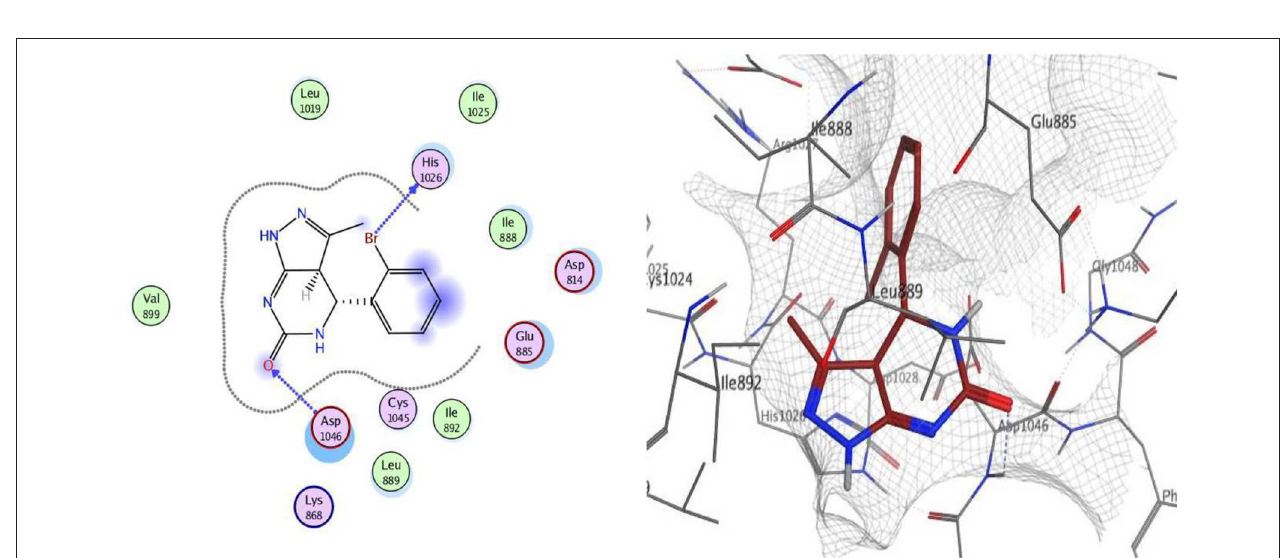
FIGURE 4 | 2D and 3D interaction map of compound 9 within the active site of VEGFR2 (4ASD).